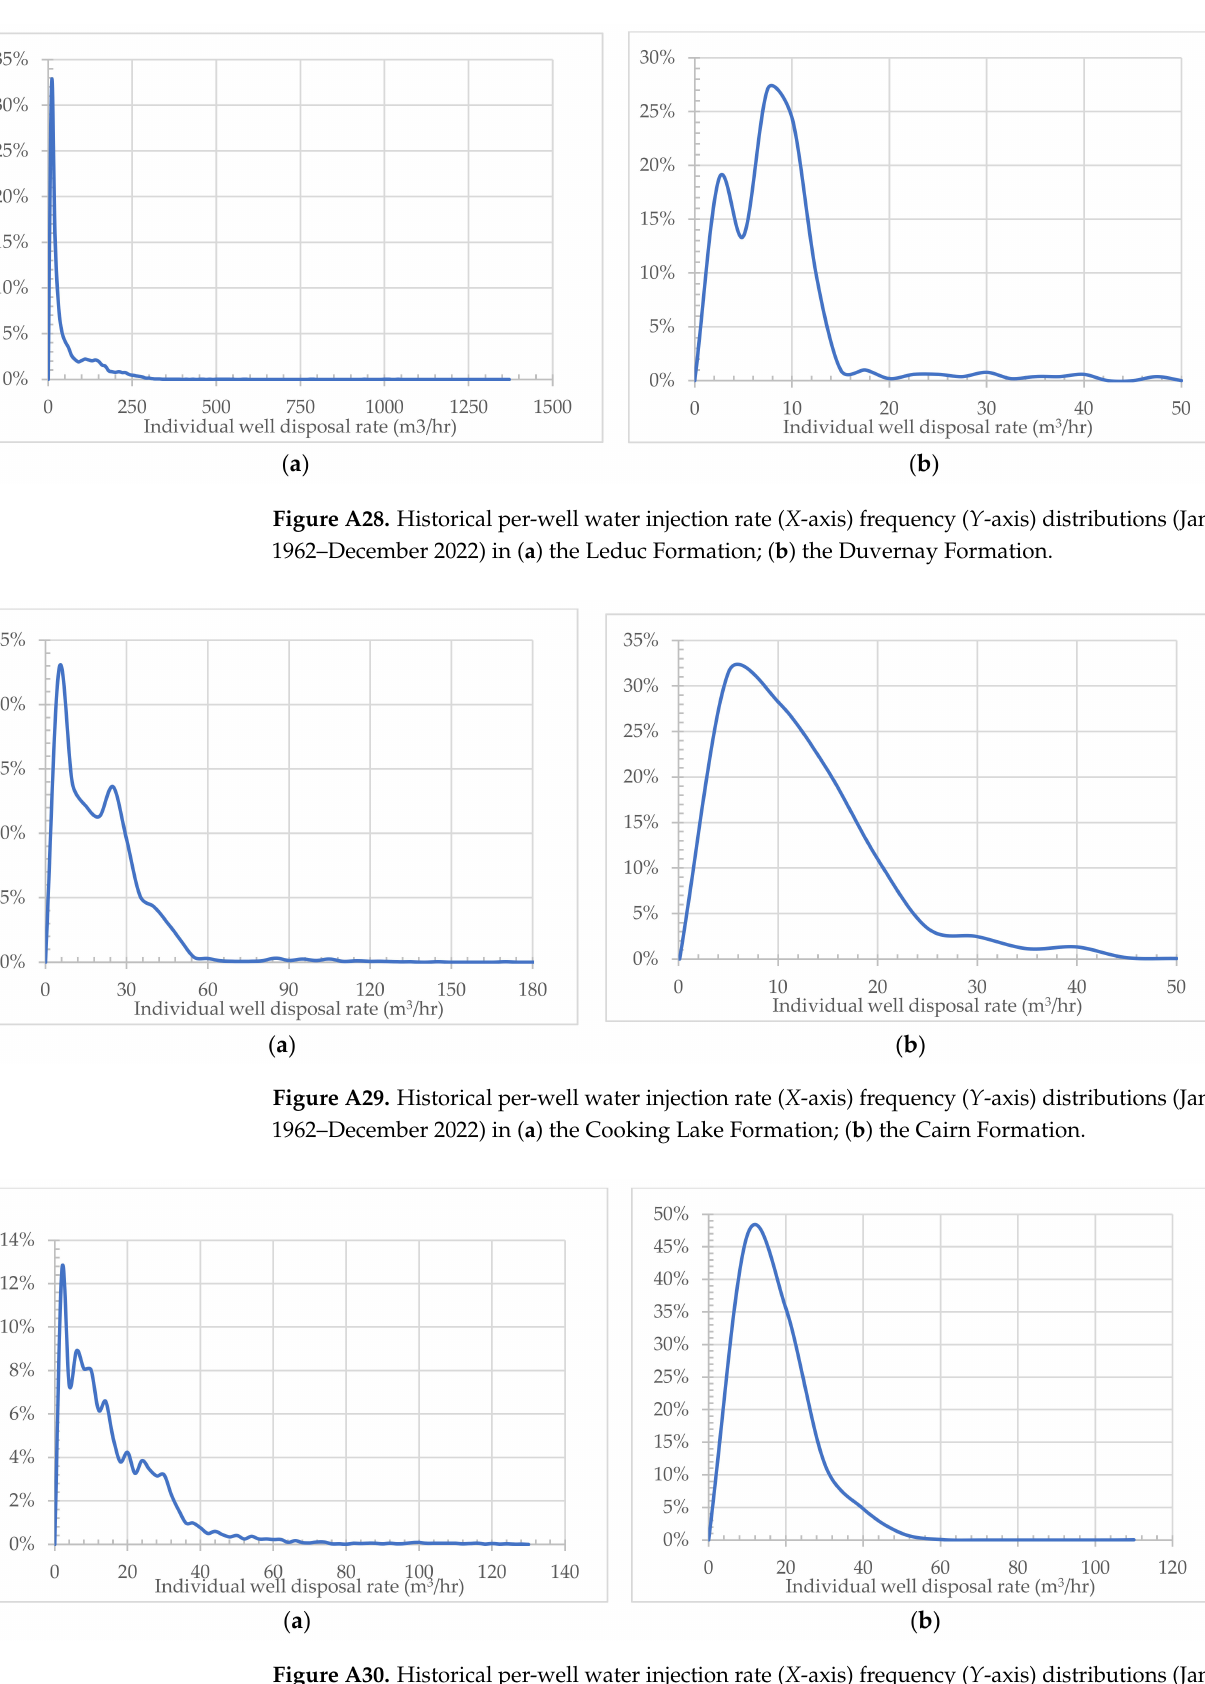
Figure A30. Historical per-well water injection rate ( X -axis) frequency ( Y -axis) distributions (January 1962–December 2022) in ( a ) the Slave Point Formation; ( b ) the Gilwood